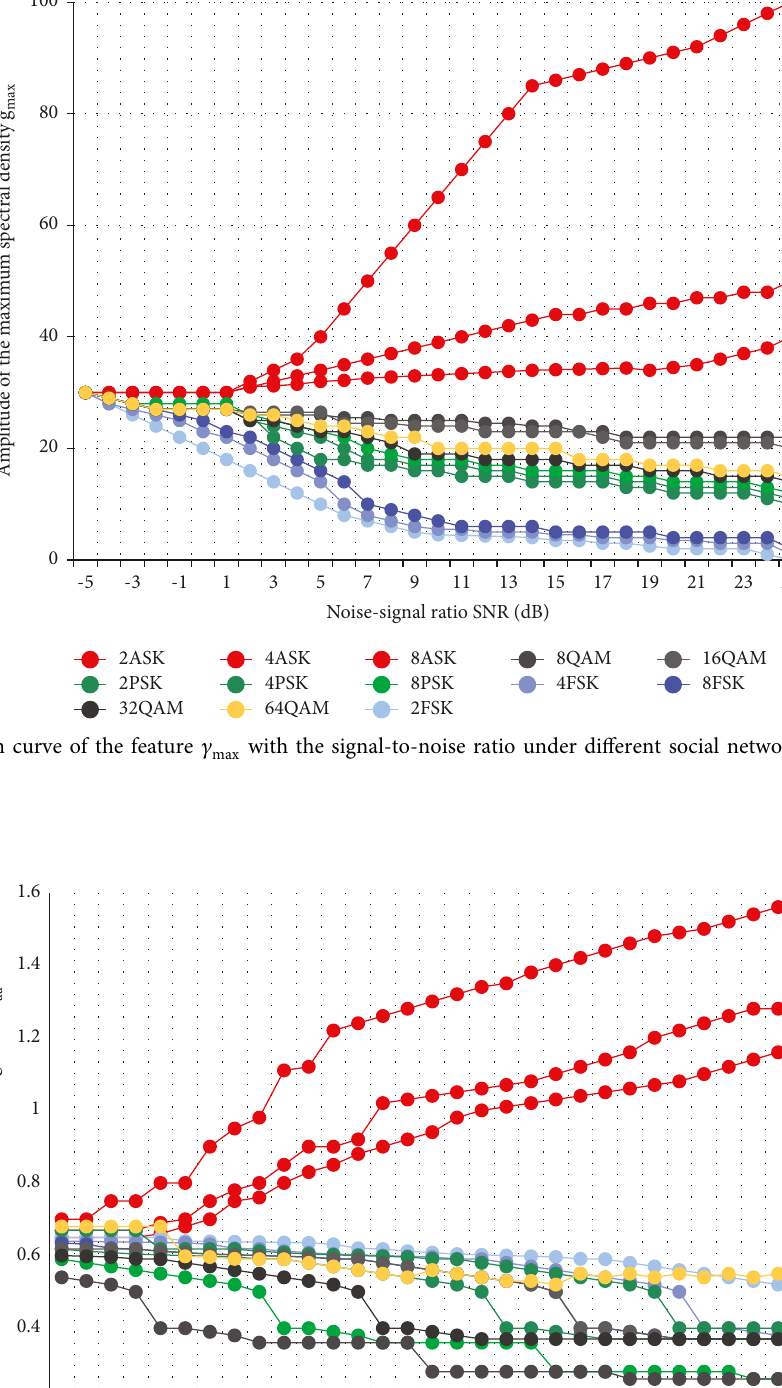
Figure 3: A variation curve of the feature δ aa with the signal-to-noise ratio under different social network crisis data